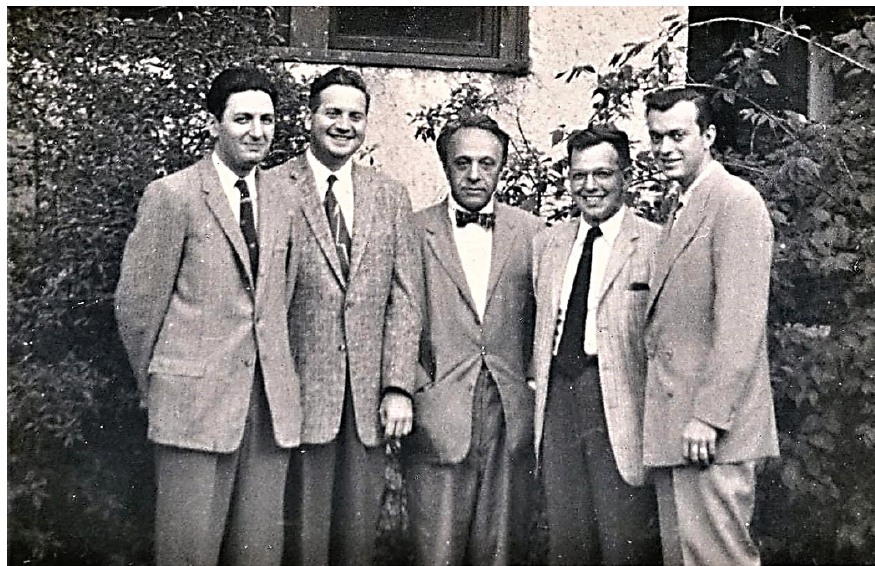
Figure 1: Karl Menger with some of his students * and colleagues † at IIT circa 1956. From left to right: Abe Sklar † , Bert Schweizer *† , Karl Menger, Tom Erber † , and Michael McKiernan.